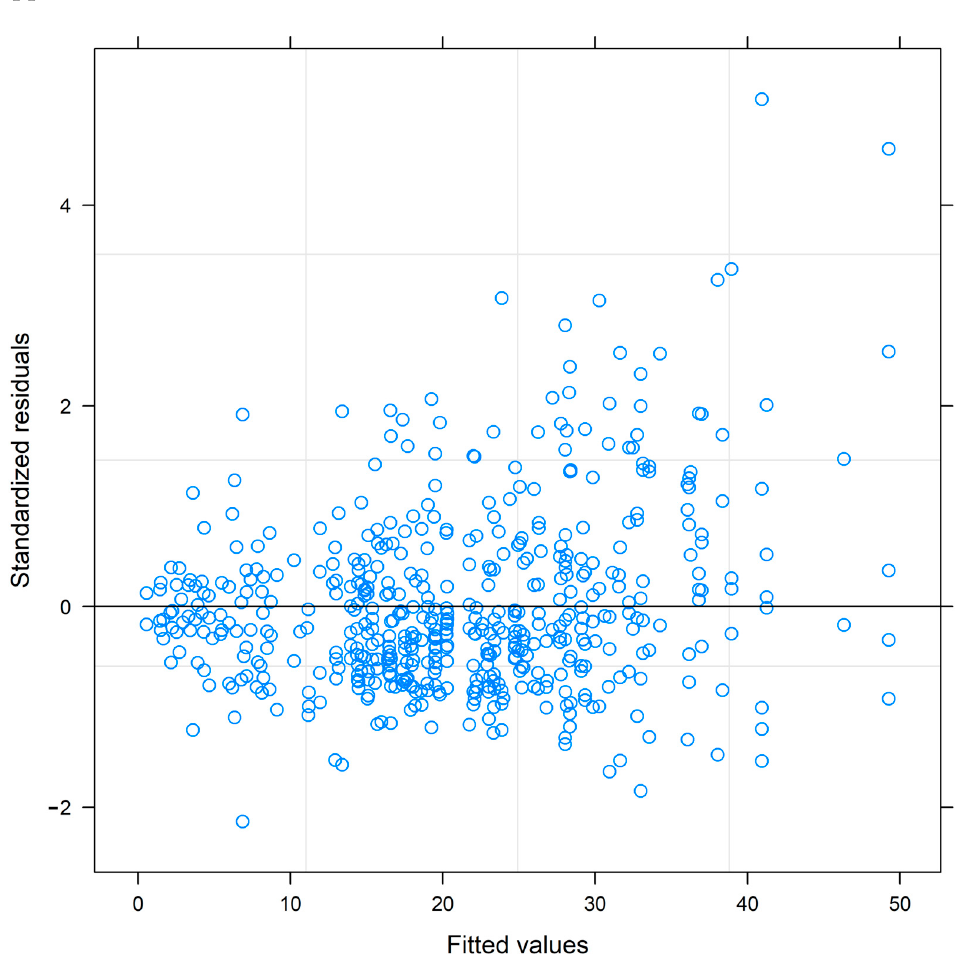
Figure A1. Residuals graph of the linear mixed effect model analyzing the carabid beetle activity density. Table A1. Full species list of all caught ground beetles in total, and separated by the season they were caught in (May/June and